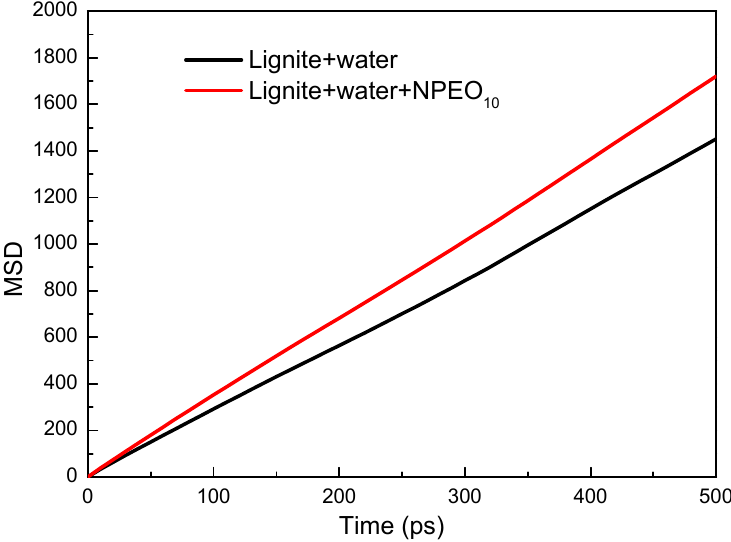
Figure 6. MSD curves of water molecules in the absence and presence of NPEO 10 ; self-diffusion coefficients were calculated and assigned to their corresponding curves.